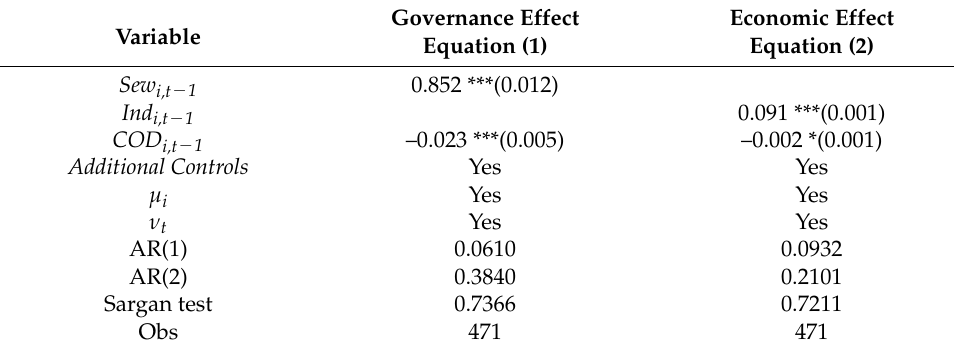
Table 6. Estimation results of ambient water quality impact on water pollution industry in two typical